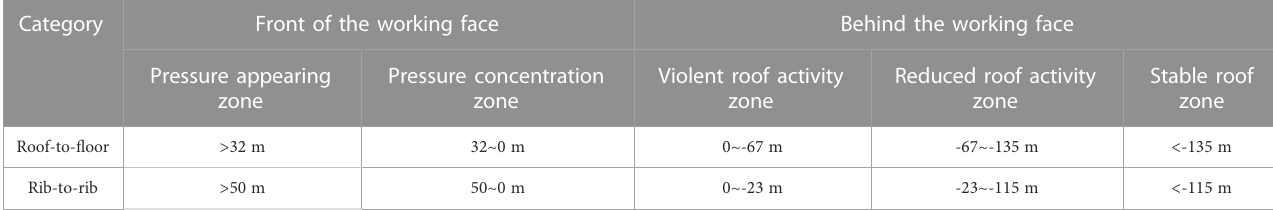
TABLE 2 Zoning table showing the displacement variation characteristics of the roadway. Category Front of the working face Behind the working face Pressure appearing